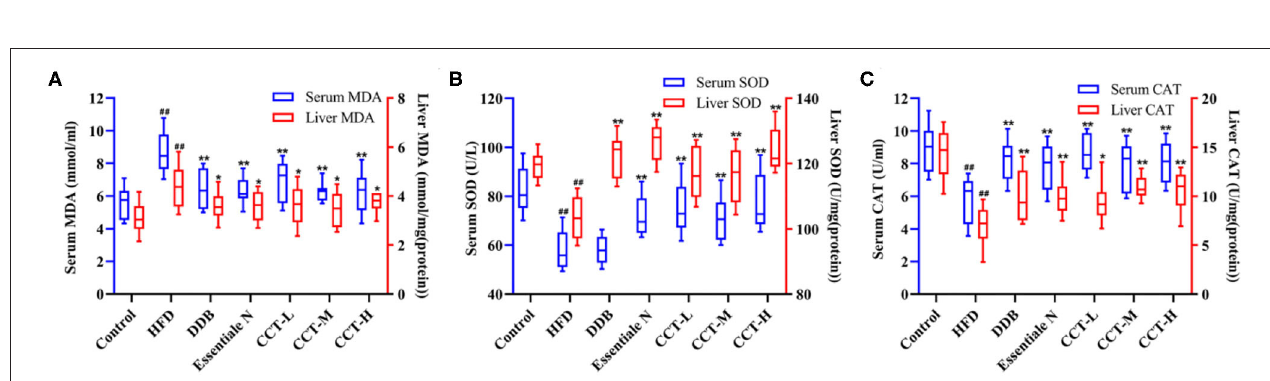
FIGURE 7 | Effects of CCT on lipid, liver and renal function biomarkers. (A) Effects of CCT on serum TC and TG. (B) Effects of CCT on liver TC and TG. (C) Effects of CCT on fecal TC and TG. (D) Effects of CCT on BUN. (E) Effects of CCT on CR. (F) Effects of CCT on UA. (G) Effects of CCT on serum AST and ALT. ## P < 0.01 vs. Control group; ** P < 0.01 vs. HFD group.